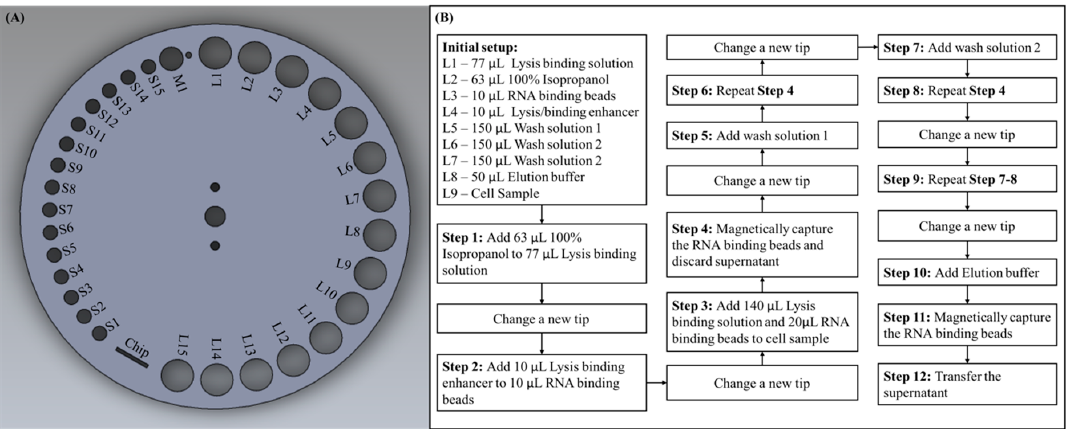
Figure 3. Experiment setup and procedure. ( A ) Detailed labels of each placement holes on the sample processing disc. ( B ) Process flow for automated sample preparation.